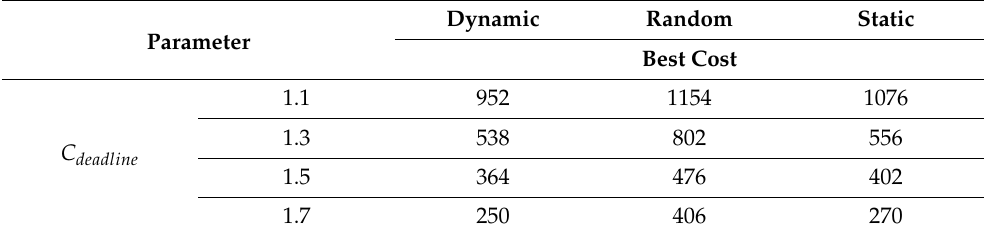
Table 5. The effect of the buffer